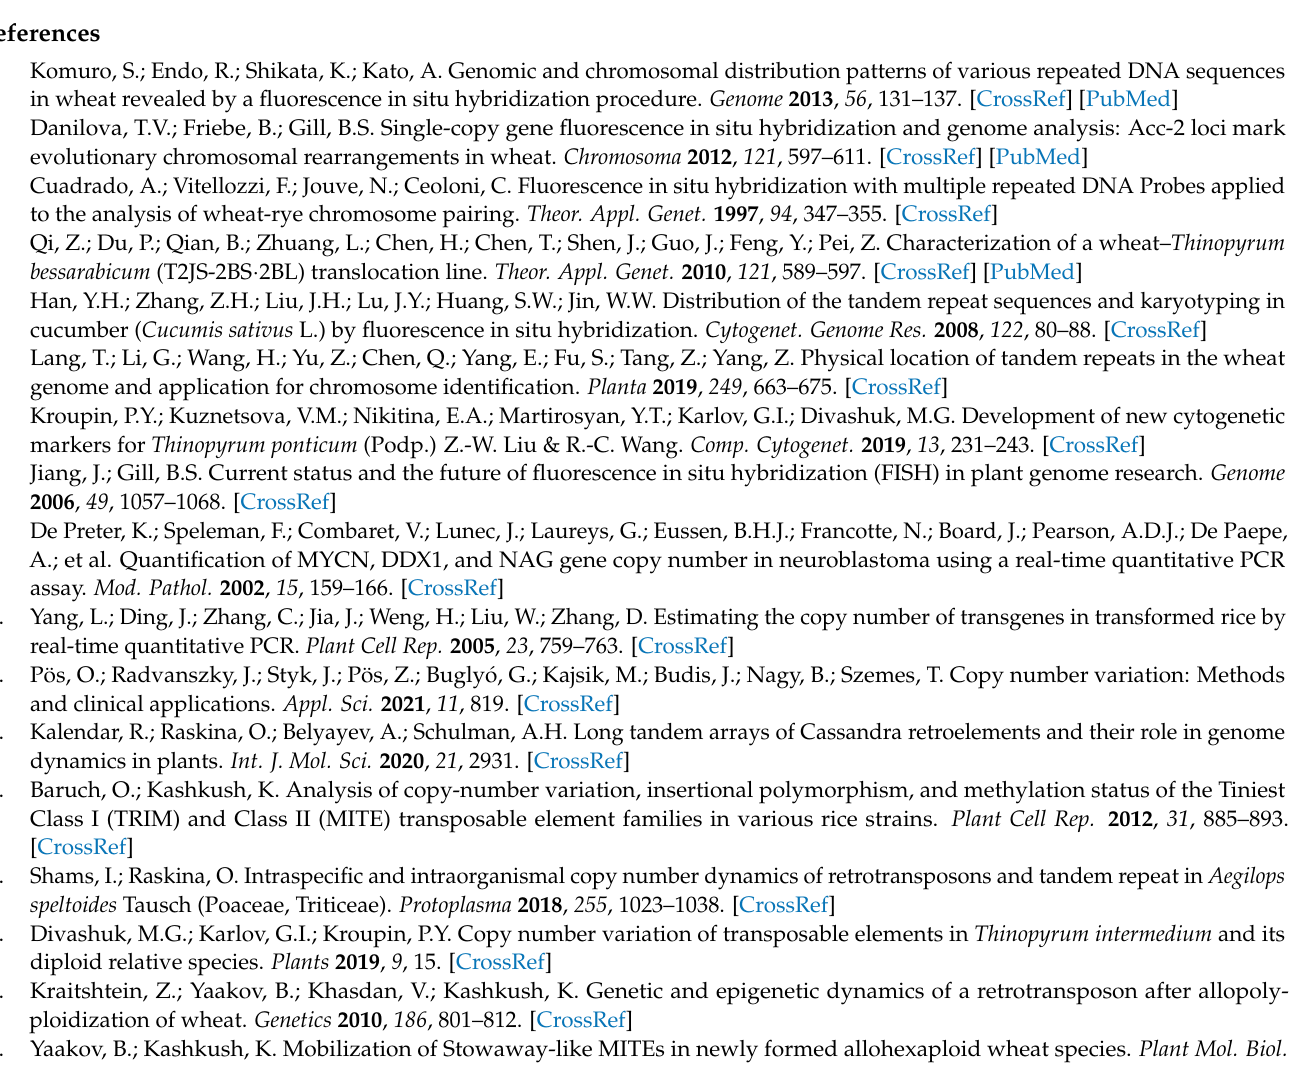
Supplementary Table S2–S11 show Cq mean and Cq standard deviation values for particular tandem repeats in the studied